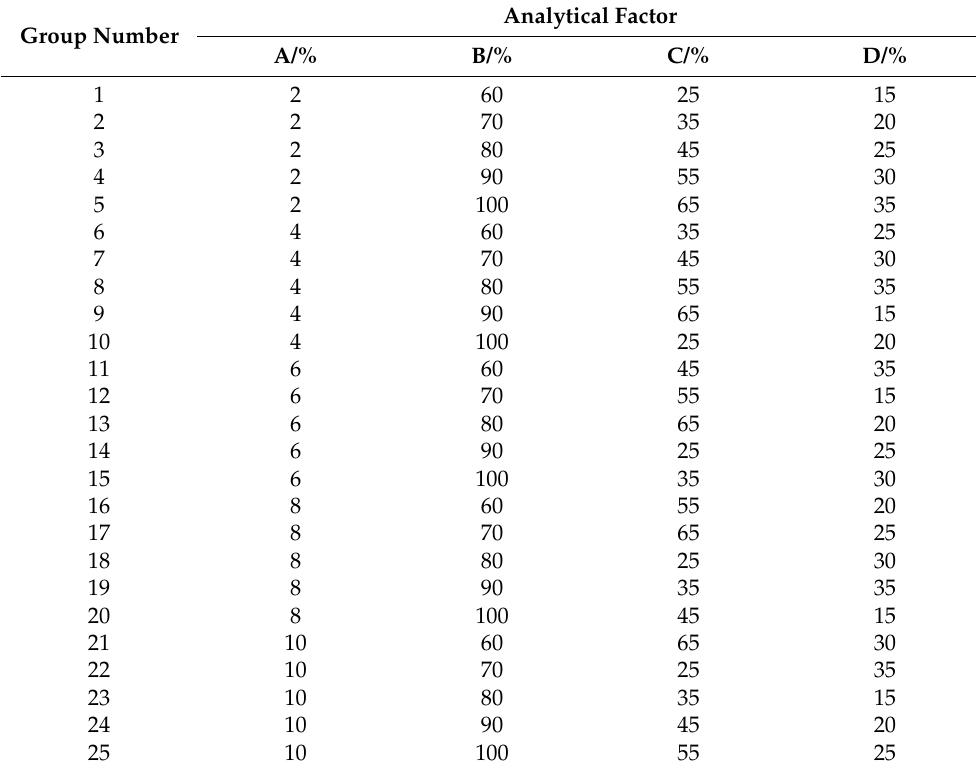
Table 2. Design of the orthogonal test for the composition of model